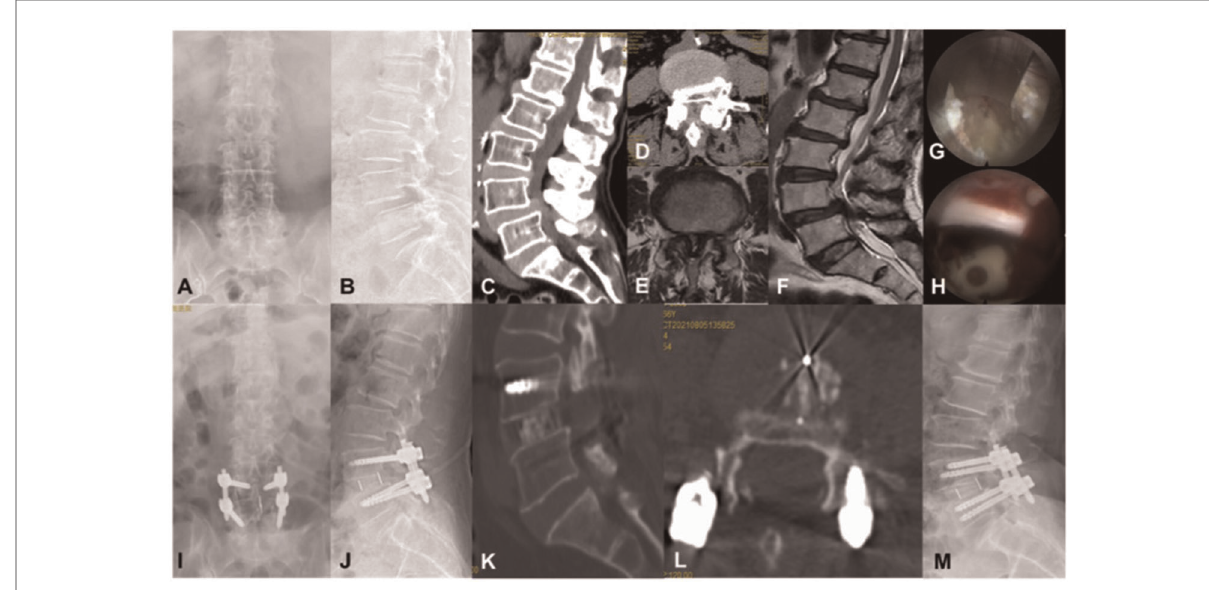
FIGURE 1 A 66-year-old female patient with discogenic low back pain and L4, 5 spinal stenosis. ( A – F ). Preoperative x-ray fi lm, CT, and MRI showed L4, 5 intervertebral disc degeneration, ligamentum fl avum hypertrophy, intervertebral disc herniation, and spinal stenosis; ( G, H ). The endplate was not damaged under the microscope during operation, and the position of the Cage and the range of decompression were satisfactory; ( I – L ). x-ray fi lm and CT at 3 days after operation showed that the position of the Cage and the pedicle screw was satisfactory with bilateral screw rod fi xation, and the decompression range was satisfactory; ( M ) x-ray fi lm at 1 year after operation showed that the internal fi xation was reliable and the intervertebral fusion was